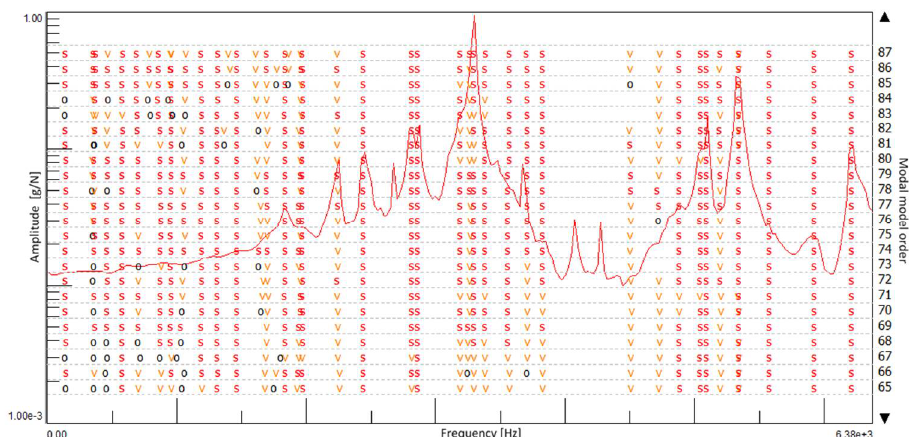
Figure 9. Stabilization diagram made with the use of the SUM indicator with eight measurement points for an undamaged full ceramic brick.